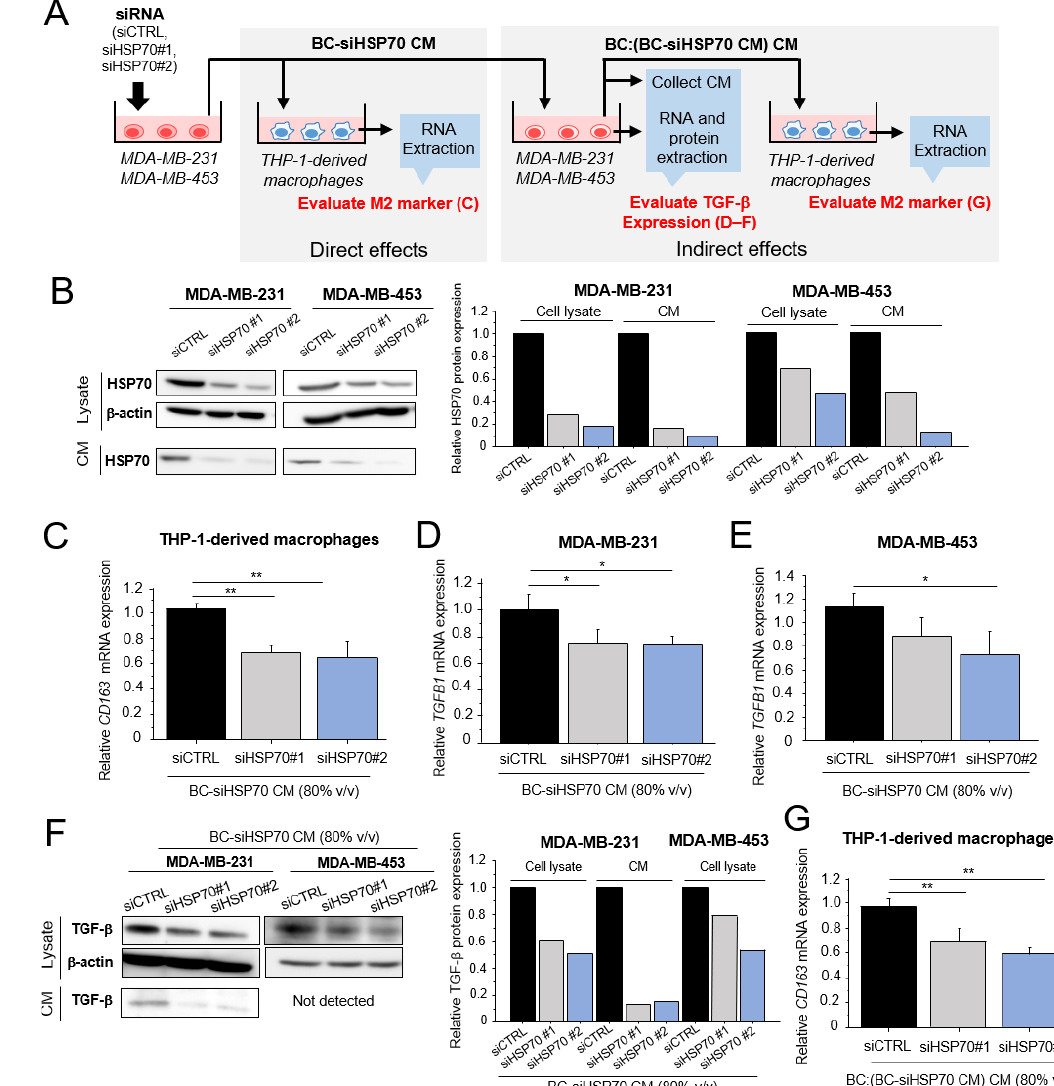
Figure 3. Direct or indirect effects of extracellular HSP70 from breast cancer cells on the